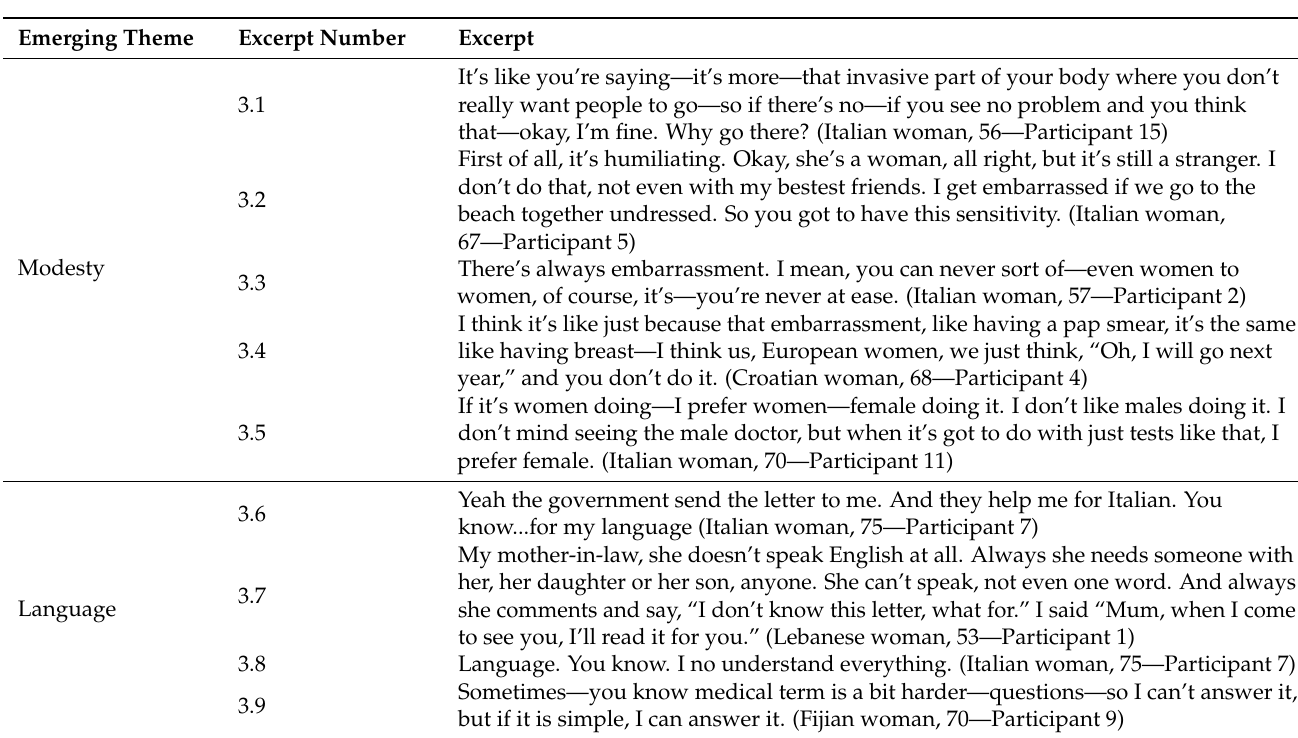
Table 3. Participant-reported cultural barriers towards